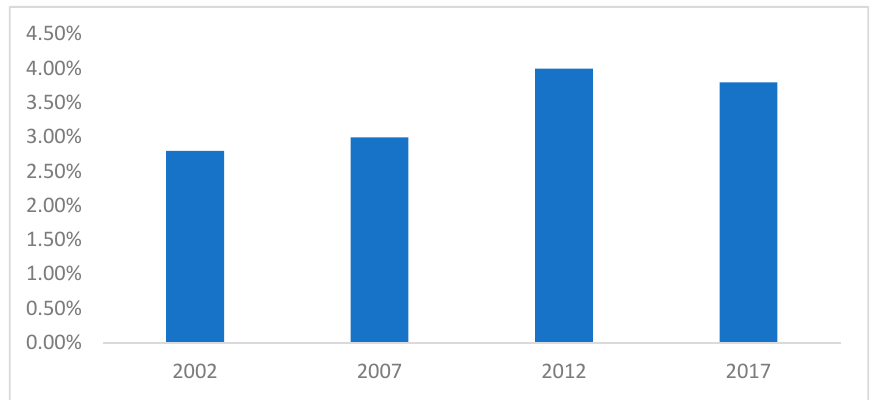
Figure 1. OOPHE out of total household expenditure.